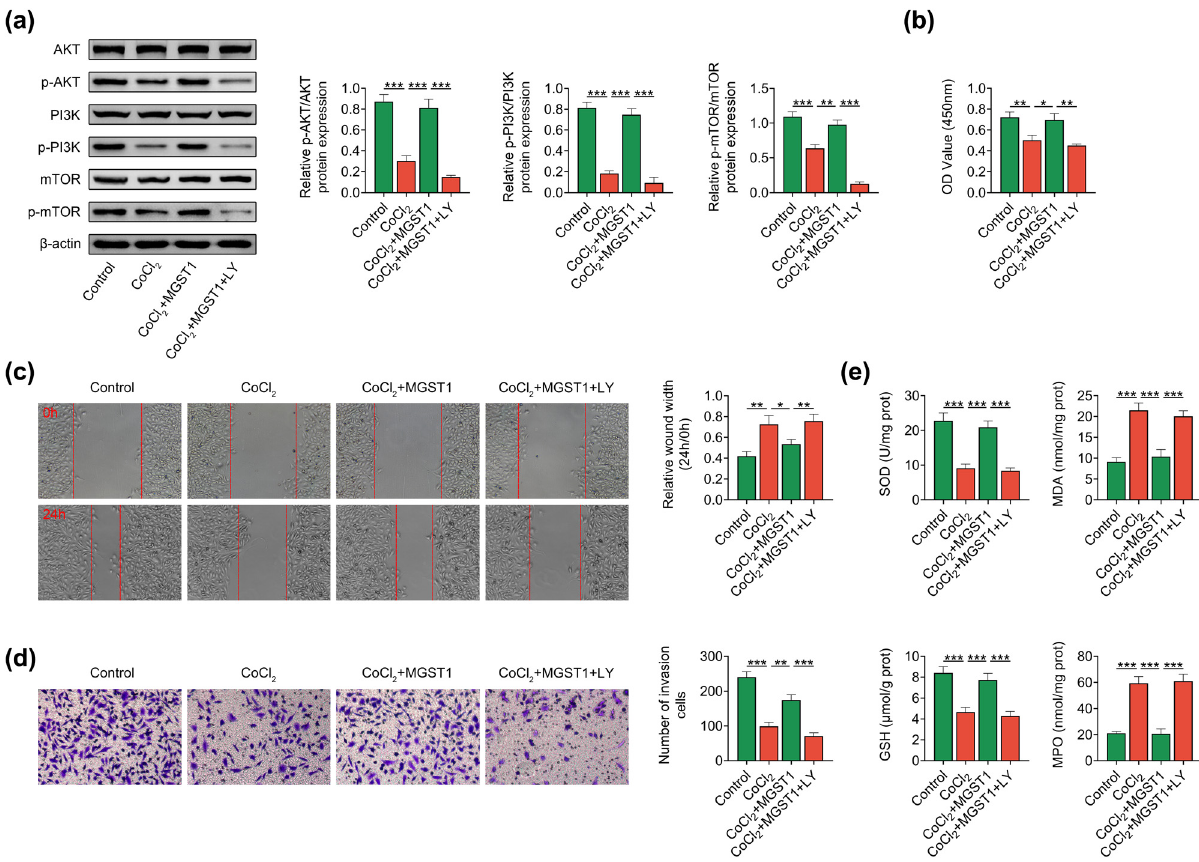
Figure 5: The e ff ects of MGST1 overexpression on PE progression were attenuated after inhibiting the PI3K/AKT/mTOR pathway. Groups were divided into the control, CoCl 2 , CoCl 2 + MGST1, and CoCl 2 + MGST1 + LY groups. LY294002 ( LY ) is the inhibitor for PI3K/AKT pathway. ( a ) Western blot analysis detected the levels of PI3K/AKT/mTOR pathway - associated proteins ( AKT, p - AKT, PI3K, P - PI3K, mTOR, and p - mTOR ) . ( b ) The cell proliferation was assessed through CCK - 8 assay. ( c and d ) The cell migration and invasion were evaluated through wound healing and Transwell assays. ( e ) The concentrations of oxidative stress - related proteins ( SOD, MDA, GSH, and MPO ) were tested through ELISA. * P < 0.05, ** P < 0.01, *** P <